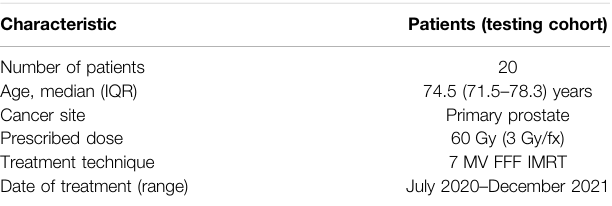
TABLE 1 | Overview of the patient characteristics and treatment information for the tested dataset. Characteristic Patients (testing cohort) Number of patients